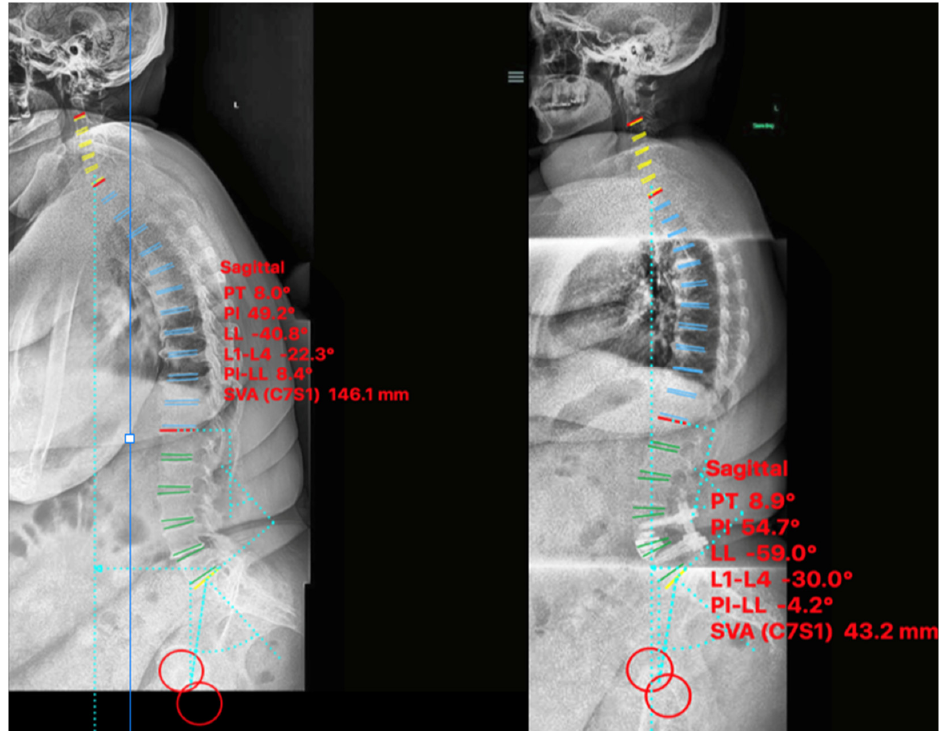
Figure 4. Case II. Pre-psoas interbody fusion for L4–5 spondylolisthesis with anterior column release and with an expandable 30° cage. Lateral standing scoliosis radiographs. Pre-operative imaging ( left ), 3-months post-operative imaging ( right ).